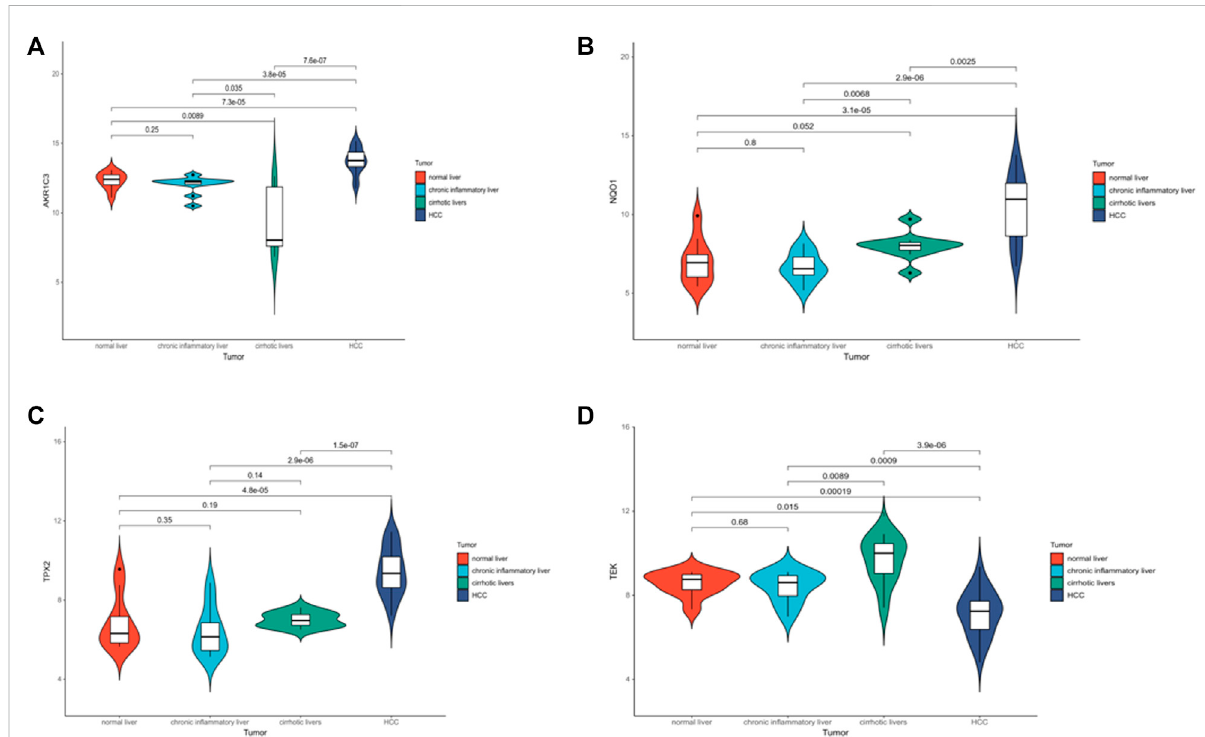
FIGURE 3 Identi fi cation of differentially expressed genes. (A) Identi fi cation of highly correlated genes between clusters 1 and 2. (B) Identi fi cation of highly correlated genes between clusters 1 and 3. (C) Identi fi cation of highly correlated genes between clusters 2 and 3. (D) Gene intersection between clusters was screened for overlapping